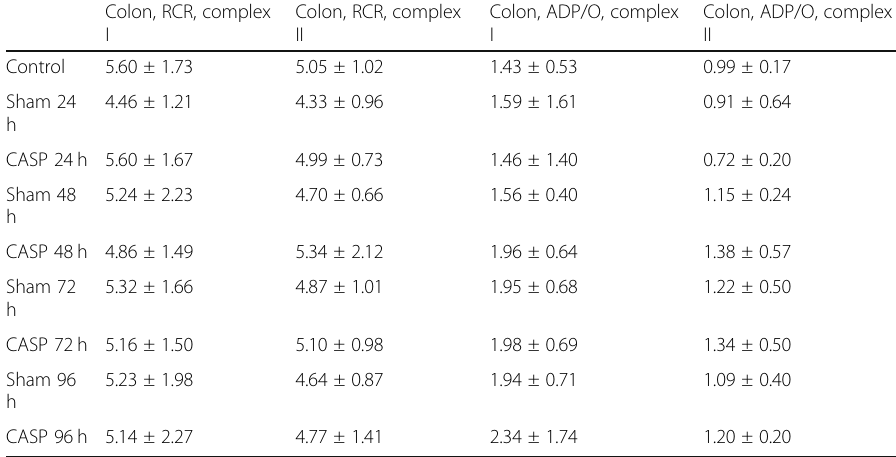
Table 3 Respiratory control ratio (state 3/state 2) for complexes I and II and ADP/O ratio for complexes I and II in the colon homogenate, data are shown as mean ± SD (control n = 9, sham n = 12, CASP n = 11 – 12, the value for each animal was calculated as the mean of three technical